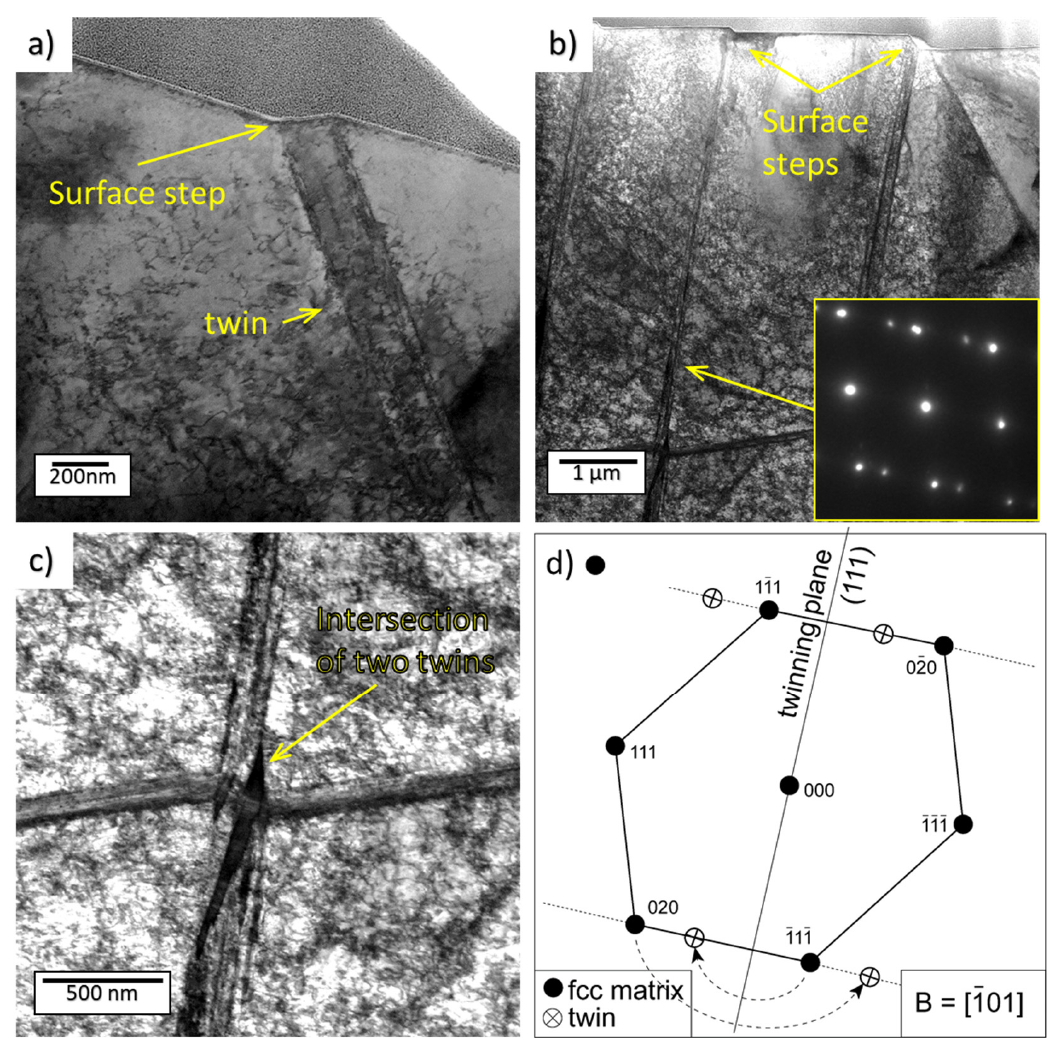
Figure 11. TEM micrographs after ( a ) 52,500 and ( b , c ) 57,750 impacts, all in BF mode, and ( d ) schema of twinning.